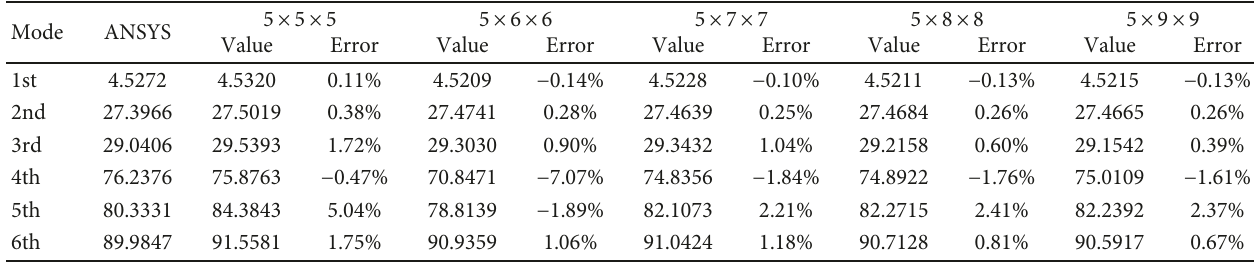
Table 2: Convergence of nondimensional frequency parameters for the fi rst six modes of the FG sandwich blade ( l = 3 , h = 20 , n = 2 , h and θ = 15 ° ).